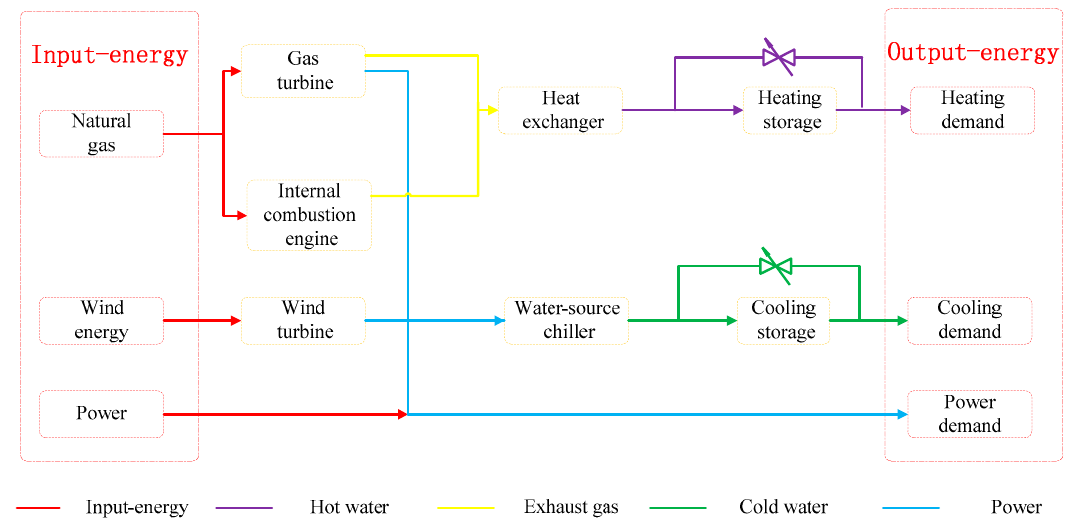
Figure 8. Selection program and energy flow of facilities of Case 4.